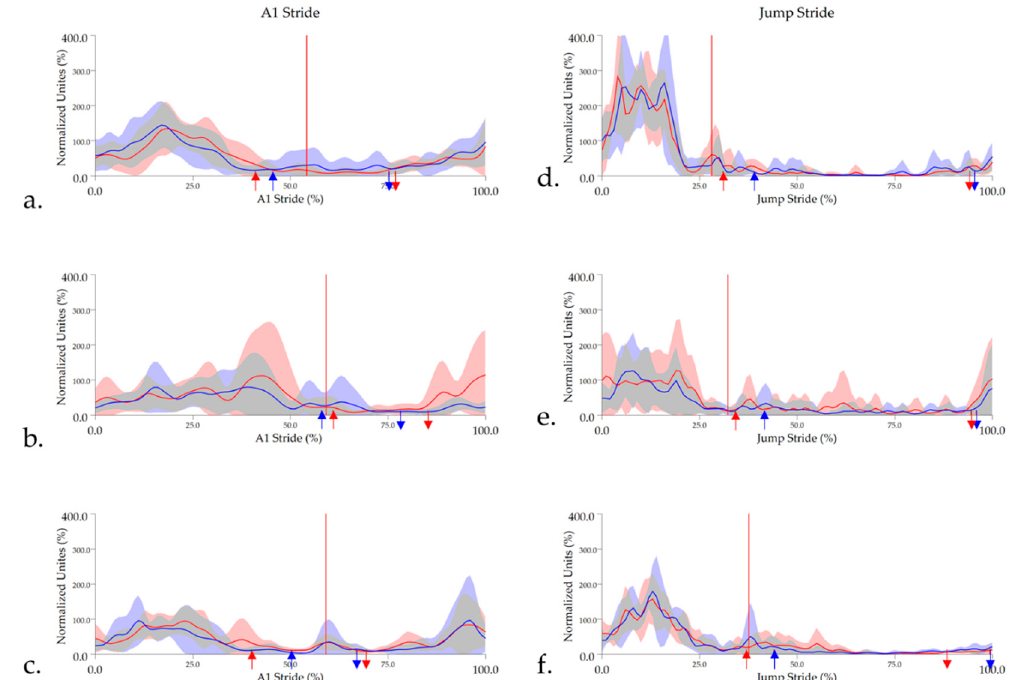
Figure 7. Mean and standard deviation time and amplitude-normalized, linear enveloped sEMG signals from biceps femoris for ( a ) High CM , ( b ) Int CM , and ( c ) Low CM horses during approach (A1) stride and ( d ) High CM , ( e ) Int CM , and ( f ) Low CM during jump stride. sEMG signals are DC-offset, high-pass filtered (40 Hz cut-off) and low-pass filtered (25 Hz). Mean data are presented for leading hindlimb (LdH) (red line) and trailing hindlimb (TrH) (blue line), with shaded areas representing the standard deviation for each limb. Arrows represent the mean biceps femoris activity onset (downward arrows) and offset (upward arrows) events for LdH (red arrows) and TrH (blue arrows). Red vertical lines represent the average hindlimb lift-off event within each group.